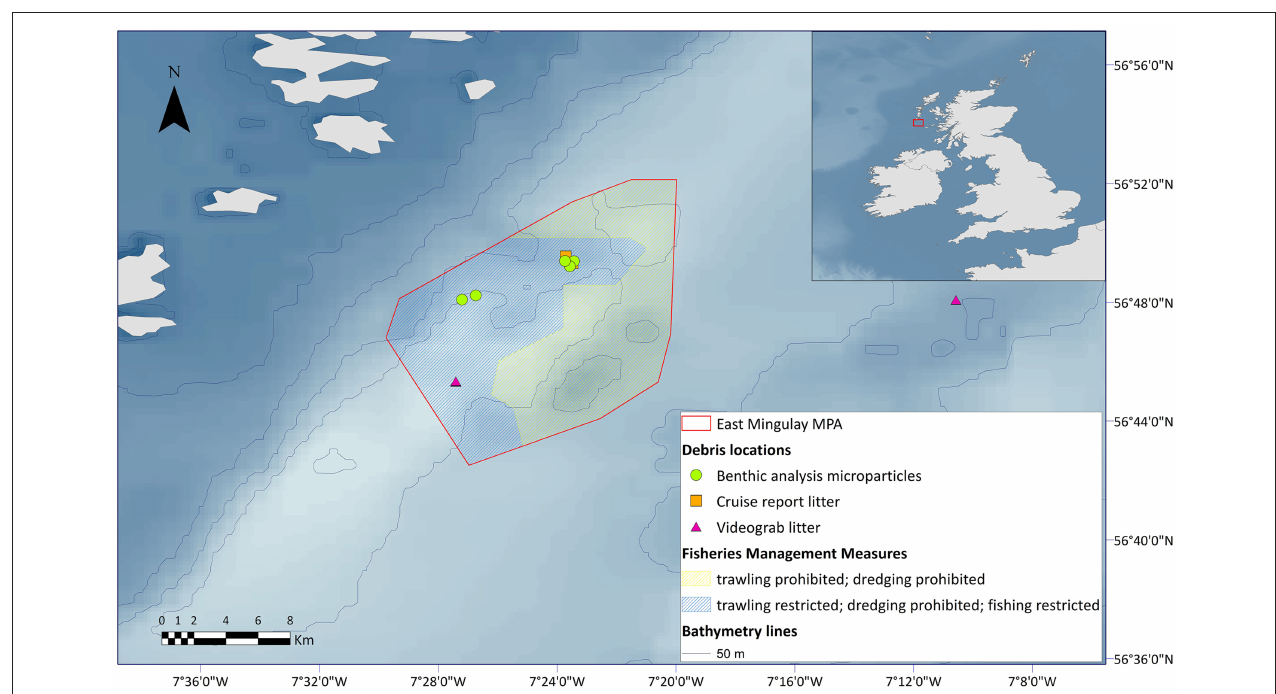
FIGURE 5 | Locations of marine litter and microparticles identified from historic cruise reports and benthic samples from the East Mingulay MPA.